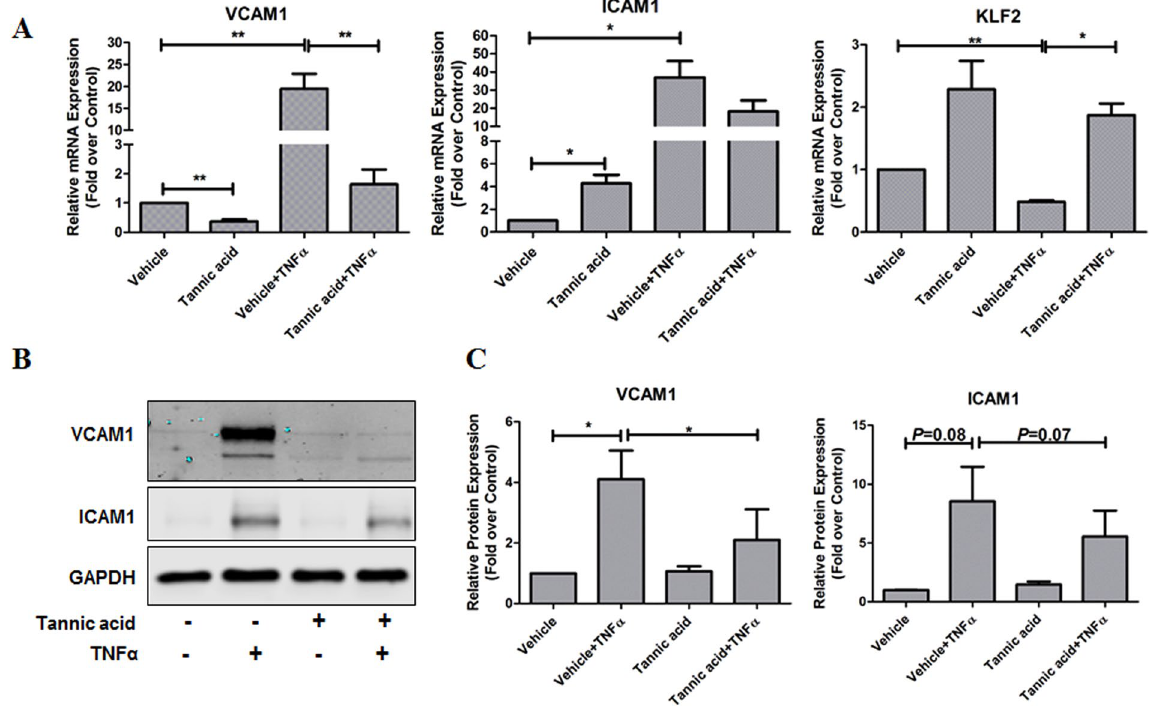
Figure 5. TA decreased TNF α -stimulated inflammatory response in HCAECs. ( A ) HCAECs were treated as described in Fig. 3 except for the exposure of TNF α for 3 h, then mRNA expression of VCAM1 and ICAM1 were determined by qPCR. Values are mean ± SEM, * p < 0.05, ** p < 0.01, n = 5.B.HCAECs were treated as described in Fig. 4, then protein expression of VCAM1 and ICAM1 were determined by Western blot. ( C ) Quantification of panel B, values are mean ± SEM, * p < 0.05, ** p < 0.01, n = 3.